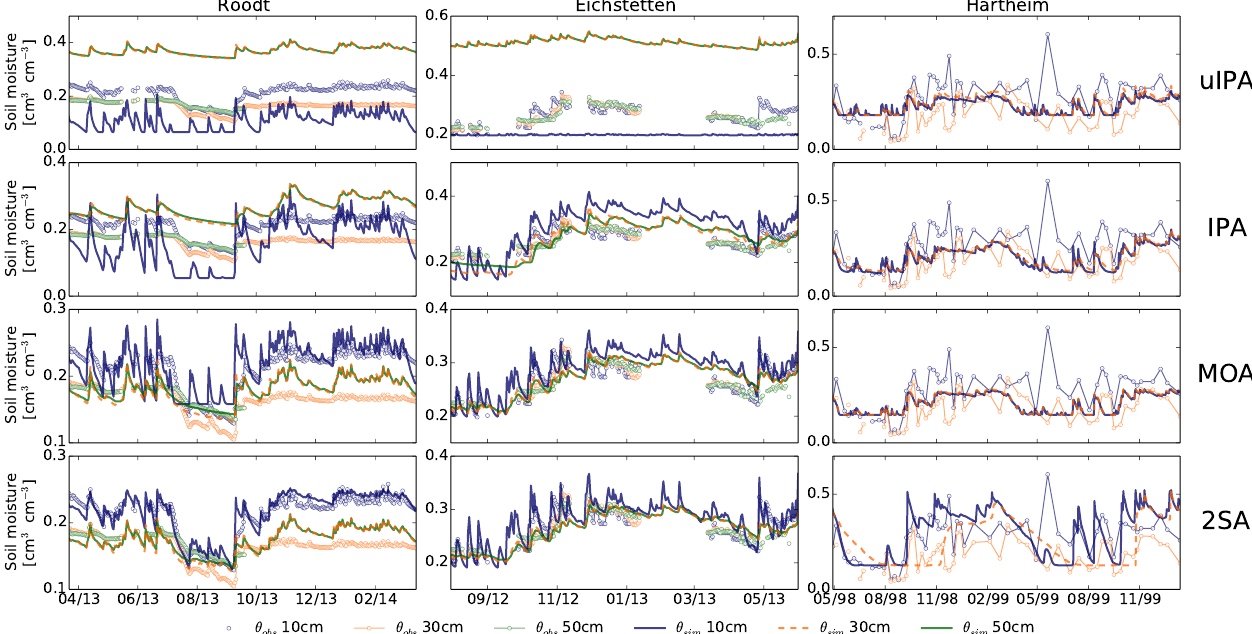
Figure 1. Observed soil moisture (circles) at each study site and the corresponding simulated soil moisture (lines), modelled with the best parameter set derived from the three different inverse model approaches. Two or three observed soil moisture time series are shown. uIPA: unconstrained isotope profile approach; IPA: isotope profile approach; MOA: multi-objective approach; 2SA: two-step approach. Roodt 18.03.13 200150100500